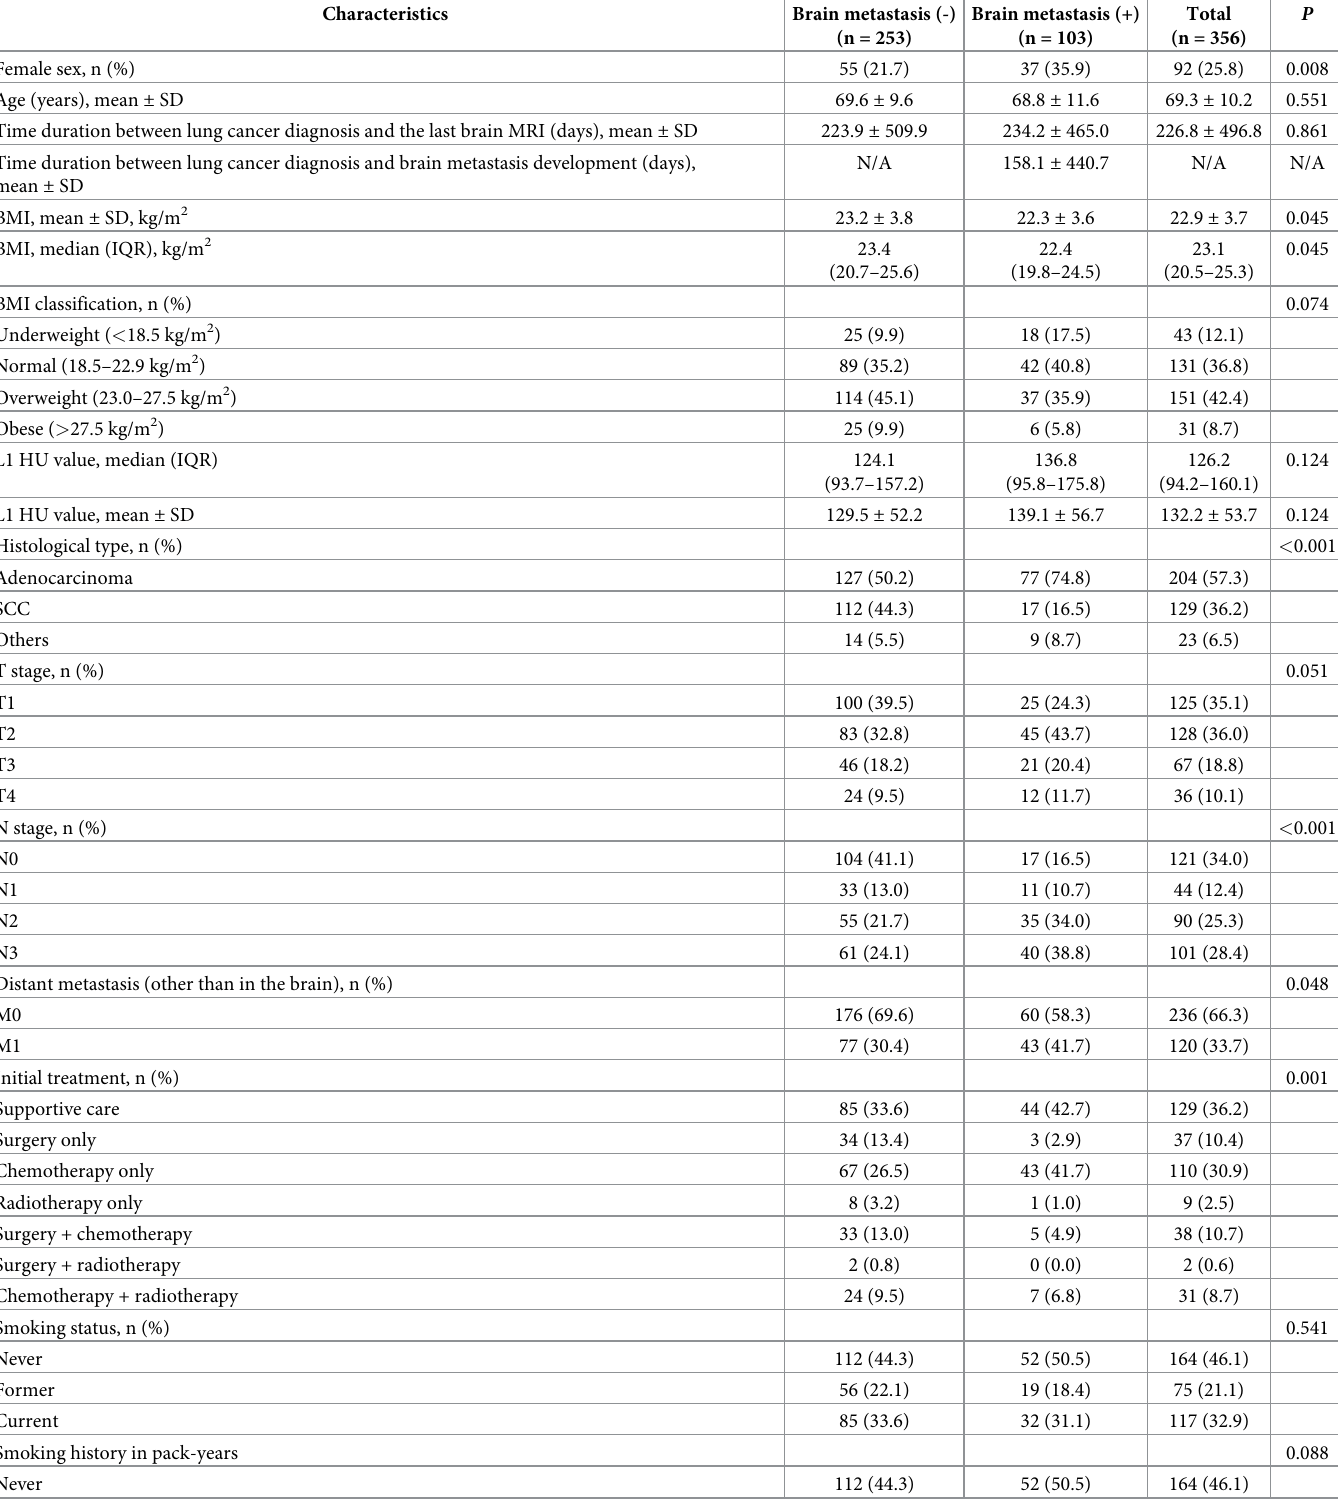
Table 1. Characteristics of the study patients according to brain